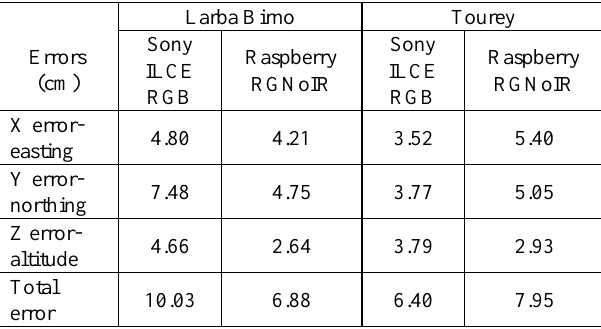
Table 8. RMSE value of the check points in centimetres